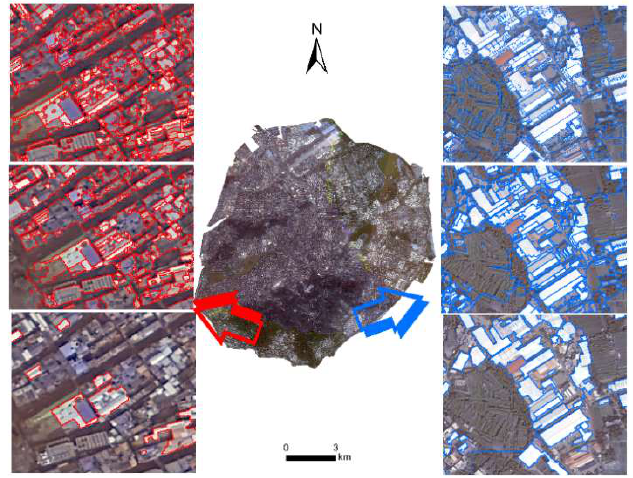
Figure 4. The segmentation at three levels in two areas (red represents a dense and high building area, blue represents a dense area but with low buildings), the parameters algorithm ‘edge’ and ‘full lambda schedule’ from top to bottom are 40 and 80, 42 and 92.8, and 41 and 98.